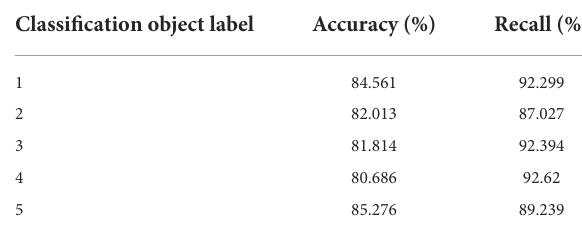
TABLE 1 Experimental results of text classification method on comments preprocessing.